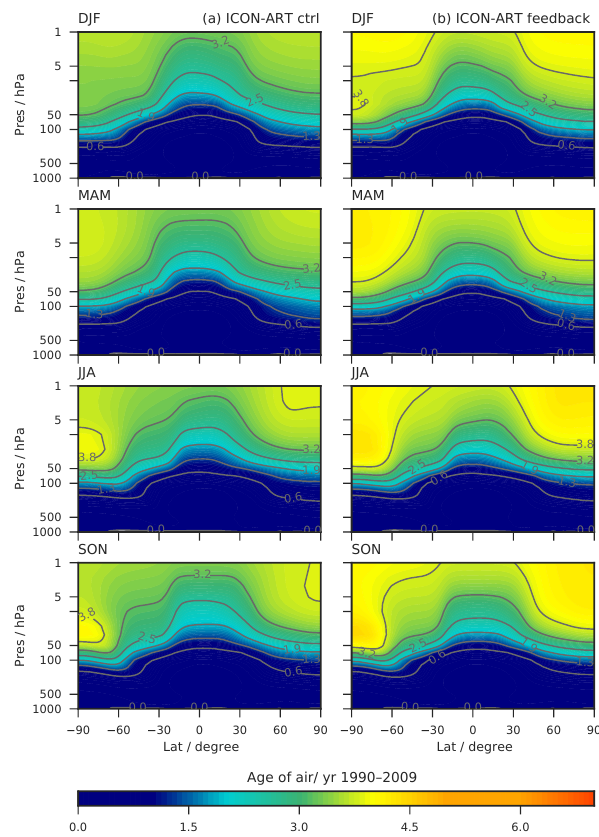
Figure 14. Latitude–height cross sections of seasonal and zonal mean ages of air (year) for ICON-ART simulations from 1990 to 2009. (a) Control run; (b) feedback simulation.